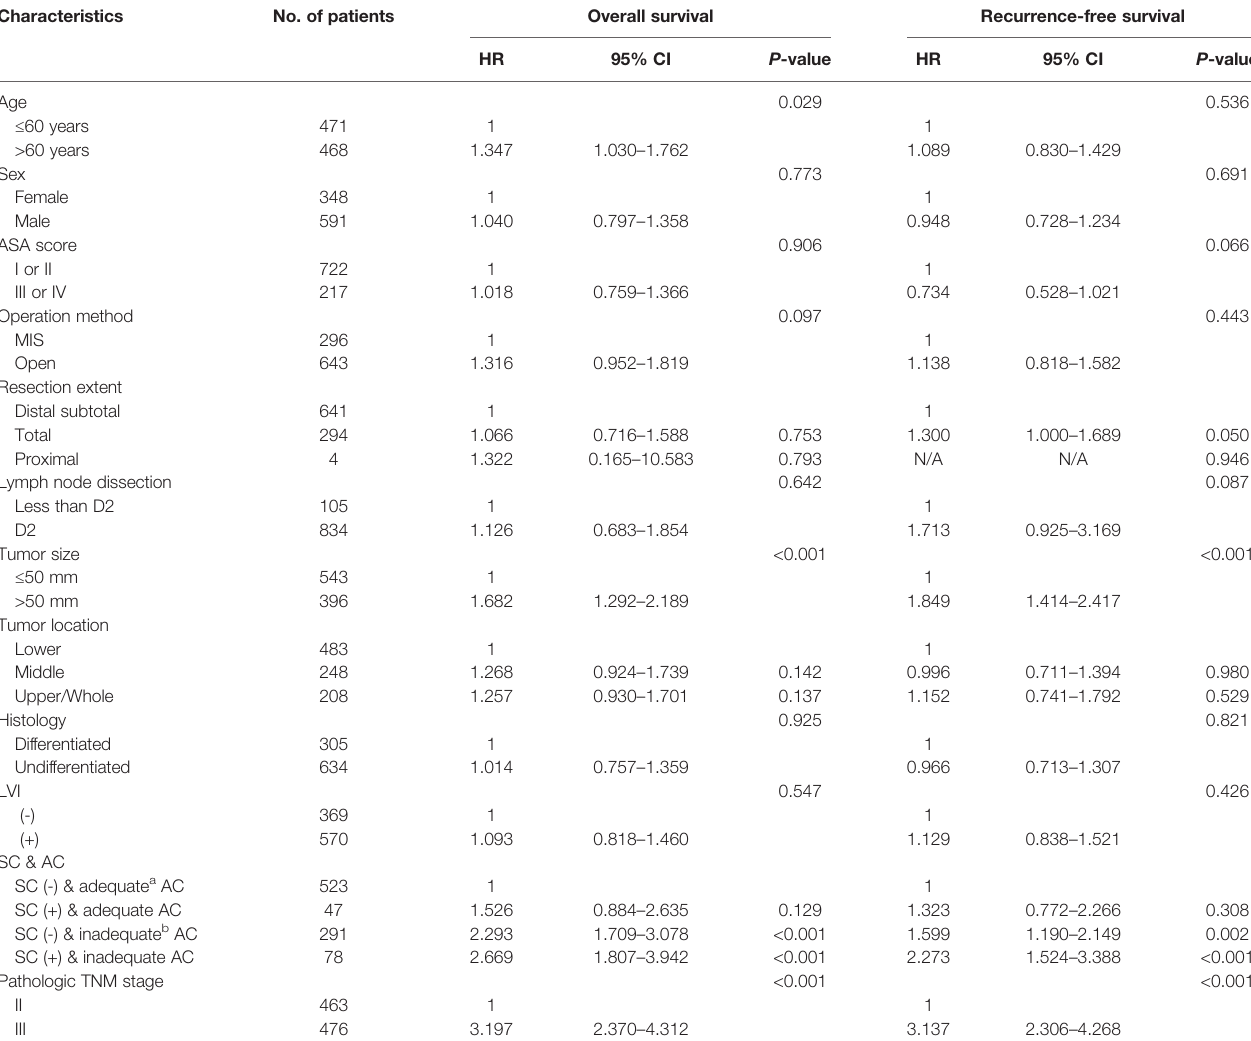
TABLE 3 | Multivariate analyses of overall and recurrence-free survival in stage II-III gastric cancer patients.